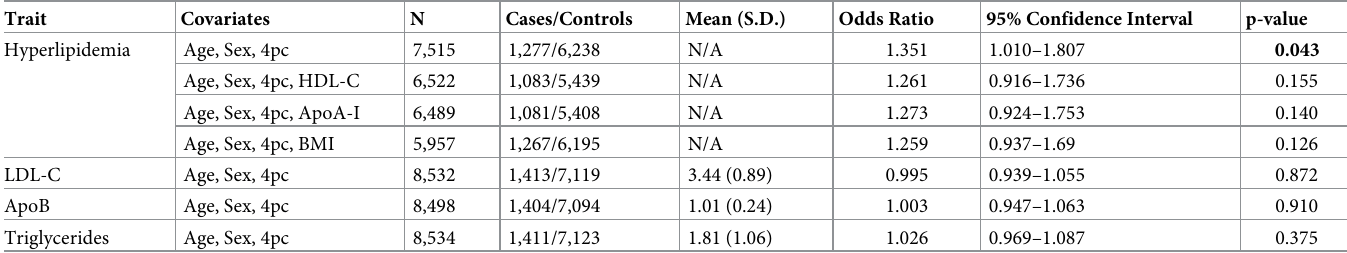
Table 4. Effect of hyperlipidemia, LDL, ApoB and triglycerides. Trait Covariates